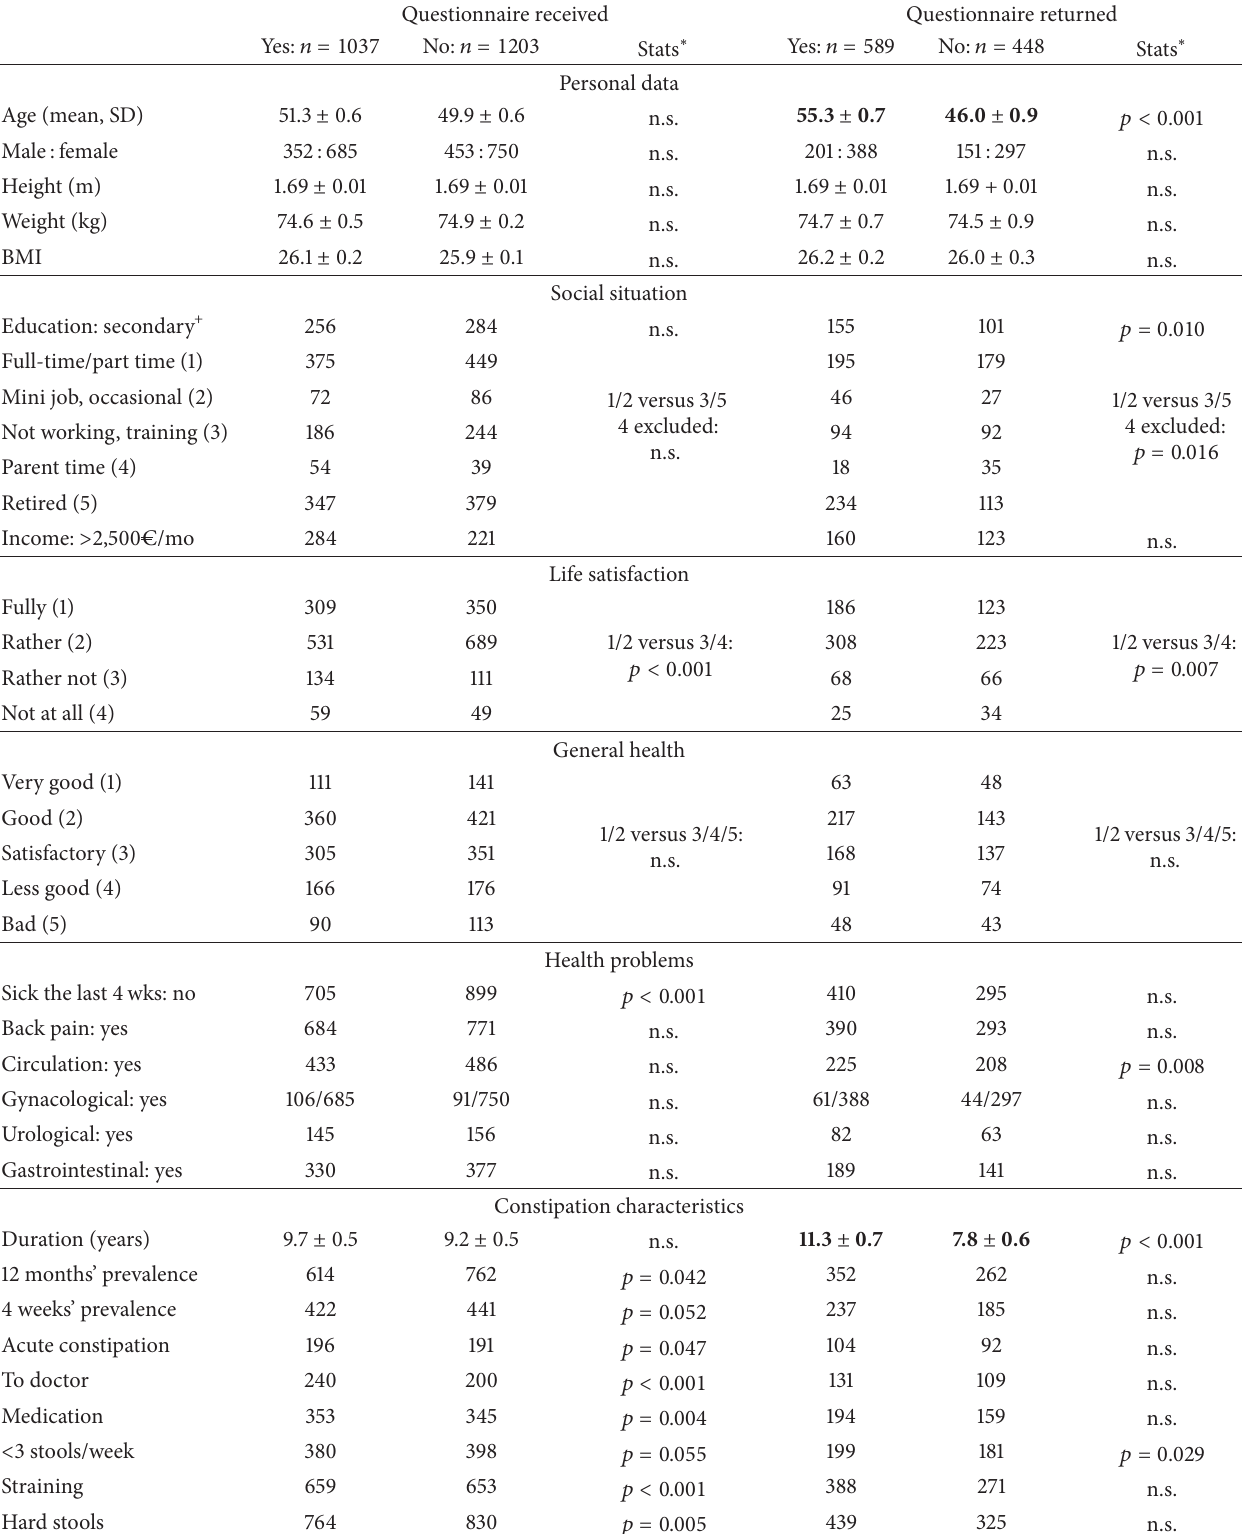
Table1:Testforself-selectionbiasesbetweenthoseprovidingapostaddressforsendingthequestionnaireandthosewhodidnotandbetween those who send back the questionnaire and those who did not. Compared are the data provided during the telephone interview prior to asking for the postal address. Data are